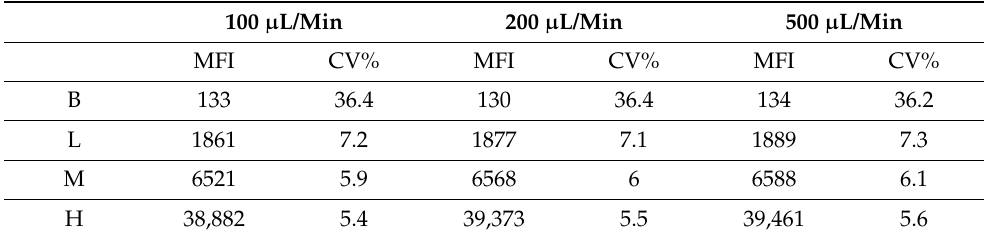
Table 1. Laser with a Gaussian beam profile.